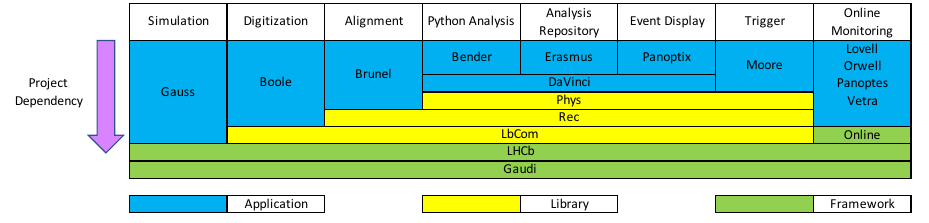
Figure 1. Overview of the LHCb Software Stack. Applications are top level projects which are written to perform computational physics tasks. Some of these applications make use of common libraries which are in turn built atop common framework